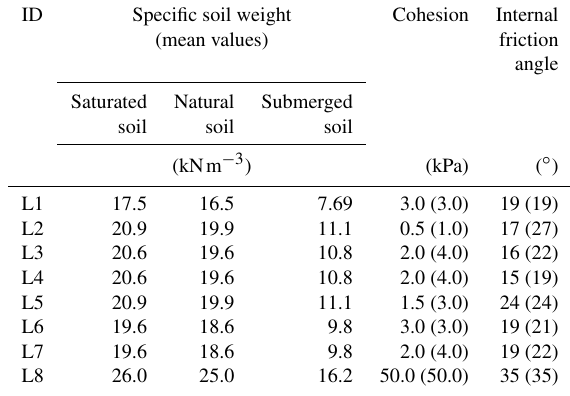
Table 4. Geotechnical parameters assigned to each lithological unit. In brackets, cohesion and internal friction angle for each lithological unit to guarantee FS > 1 in the absence of water into the soil ( m =